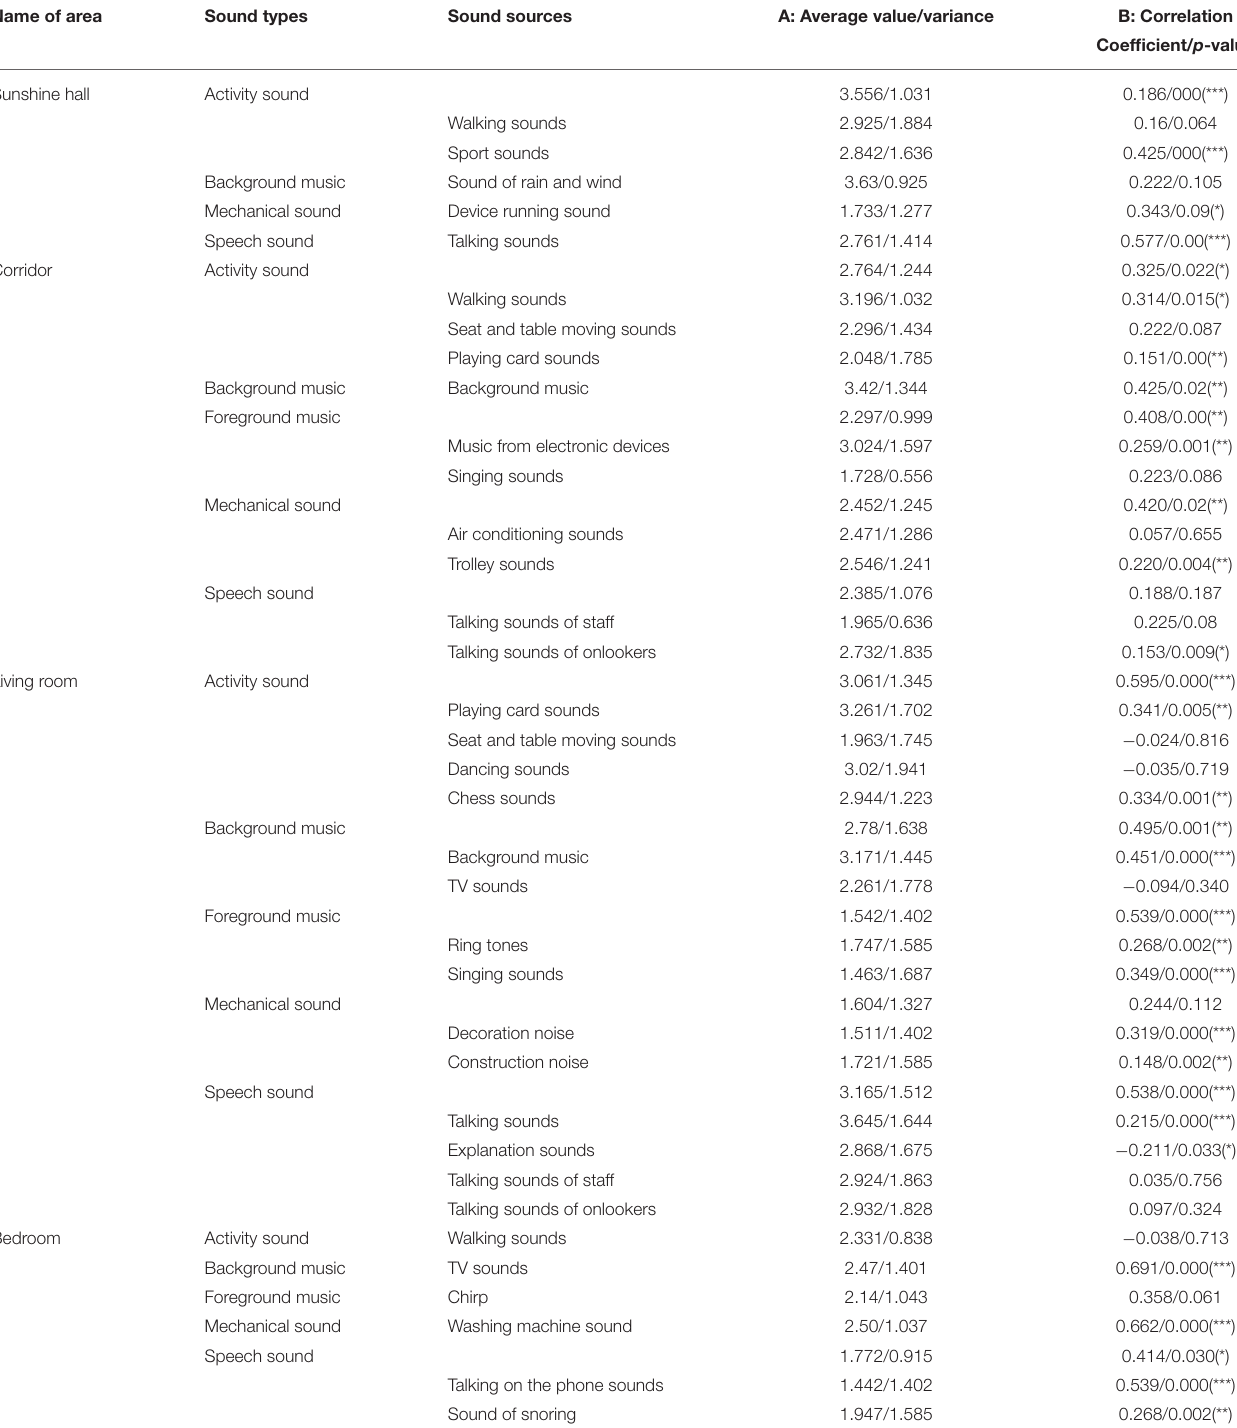
TABLE 7 | Correlation between sound sources and acoustic